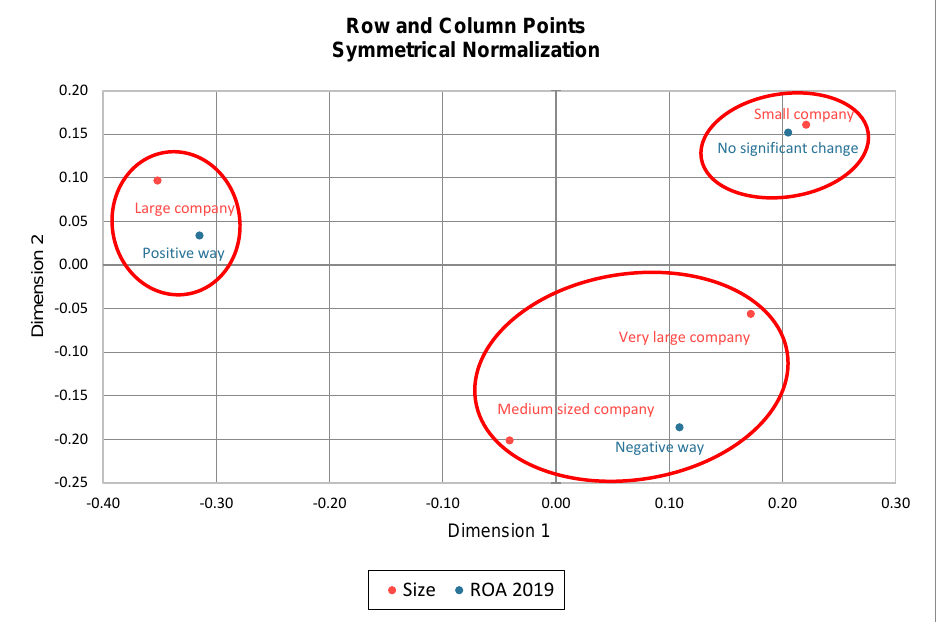
Figure 6. Correspondence map for ROA indicators in 2019 and enterprise size categories. Source: own research.